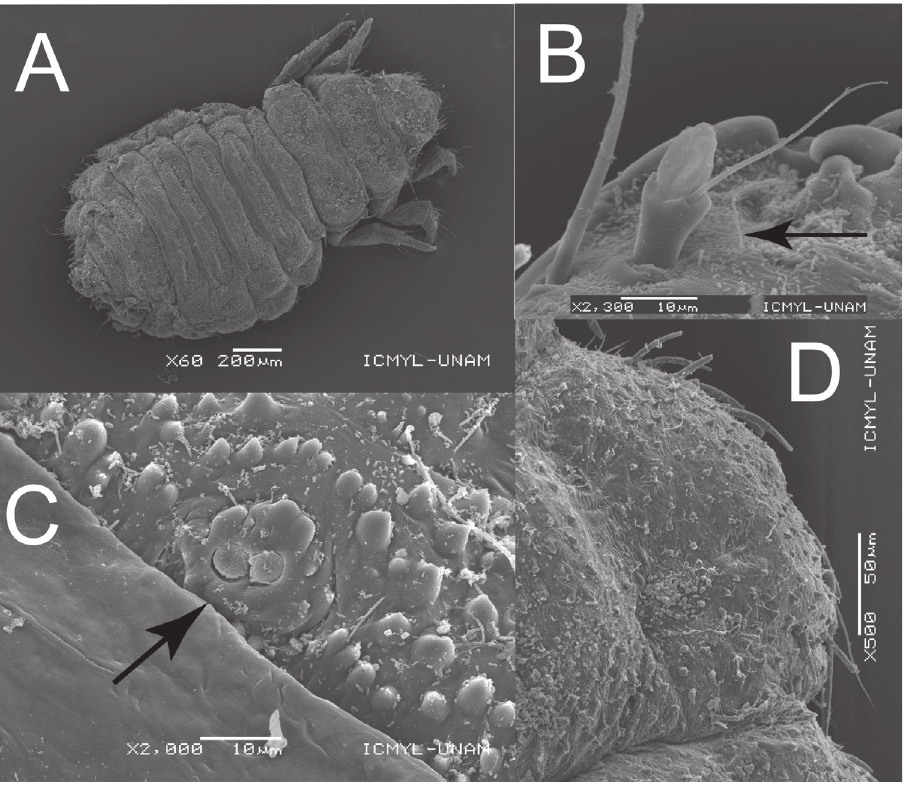
Figure 2. Scanning electron micrographs of larva of Mejicanotrichia harrisi Bueno-Soria & Barba- Álvarez, 1999 A habitus, dorsal B antenna C lacunae of abdominal segment V D lateral projection of abdominal segment V. Scale bars: 200 µm ( A ); 10 µm ( B, C ); 50 µm ( D